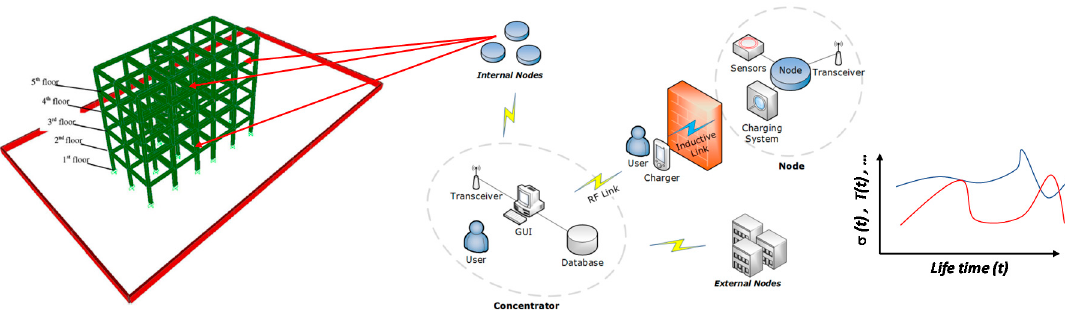
Figure 1. The WSN architecture.